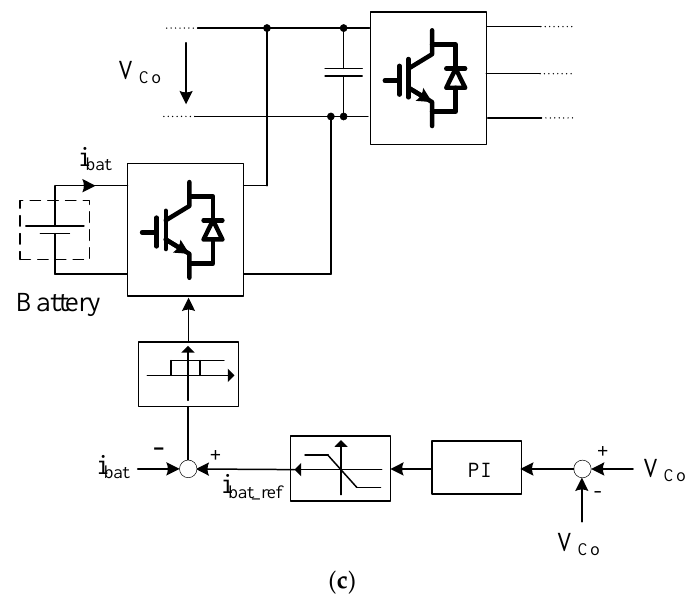
Figure 4. Control systems for ( a ) inverter of the smart-transformer; ( b ) inverter of the PV system; ( c ) DC/DC converter of the storage system.